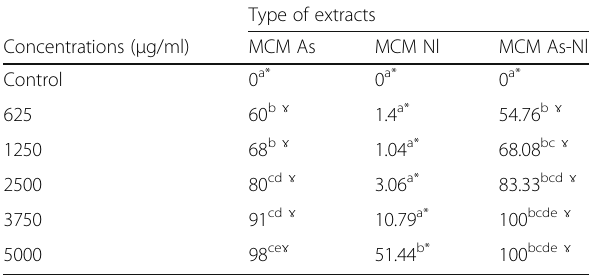
Table 4 Effect of Methylene Chloride-Methanol of Annona senegalensis, Nauclea latifolia and their mixture on L 2 larvae mortality rate (%) according to concentrations after 24 h of contact Type of extracts